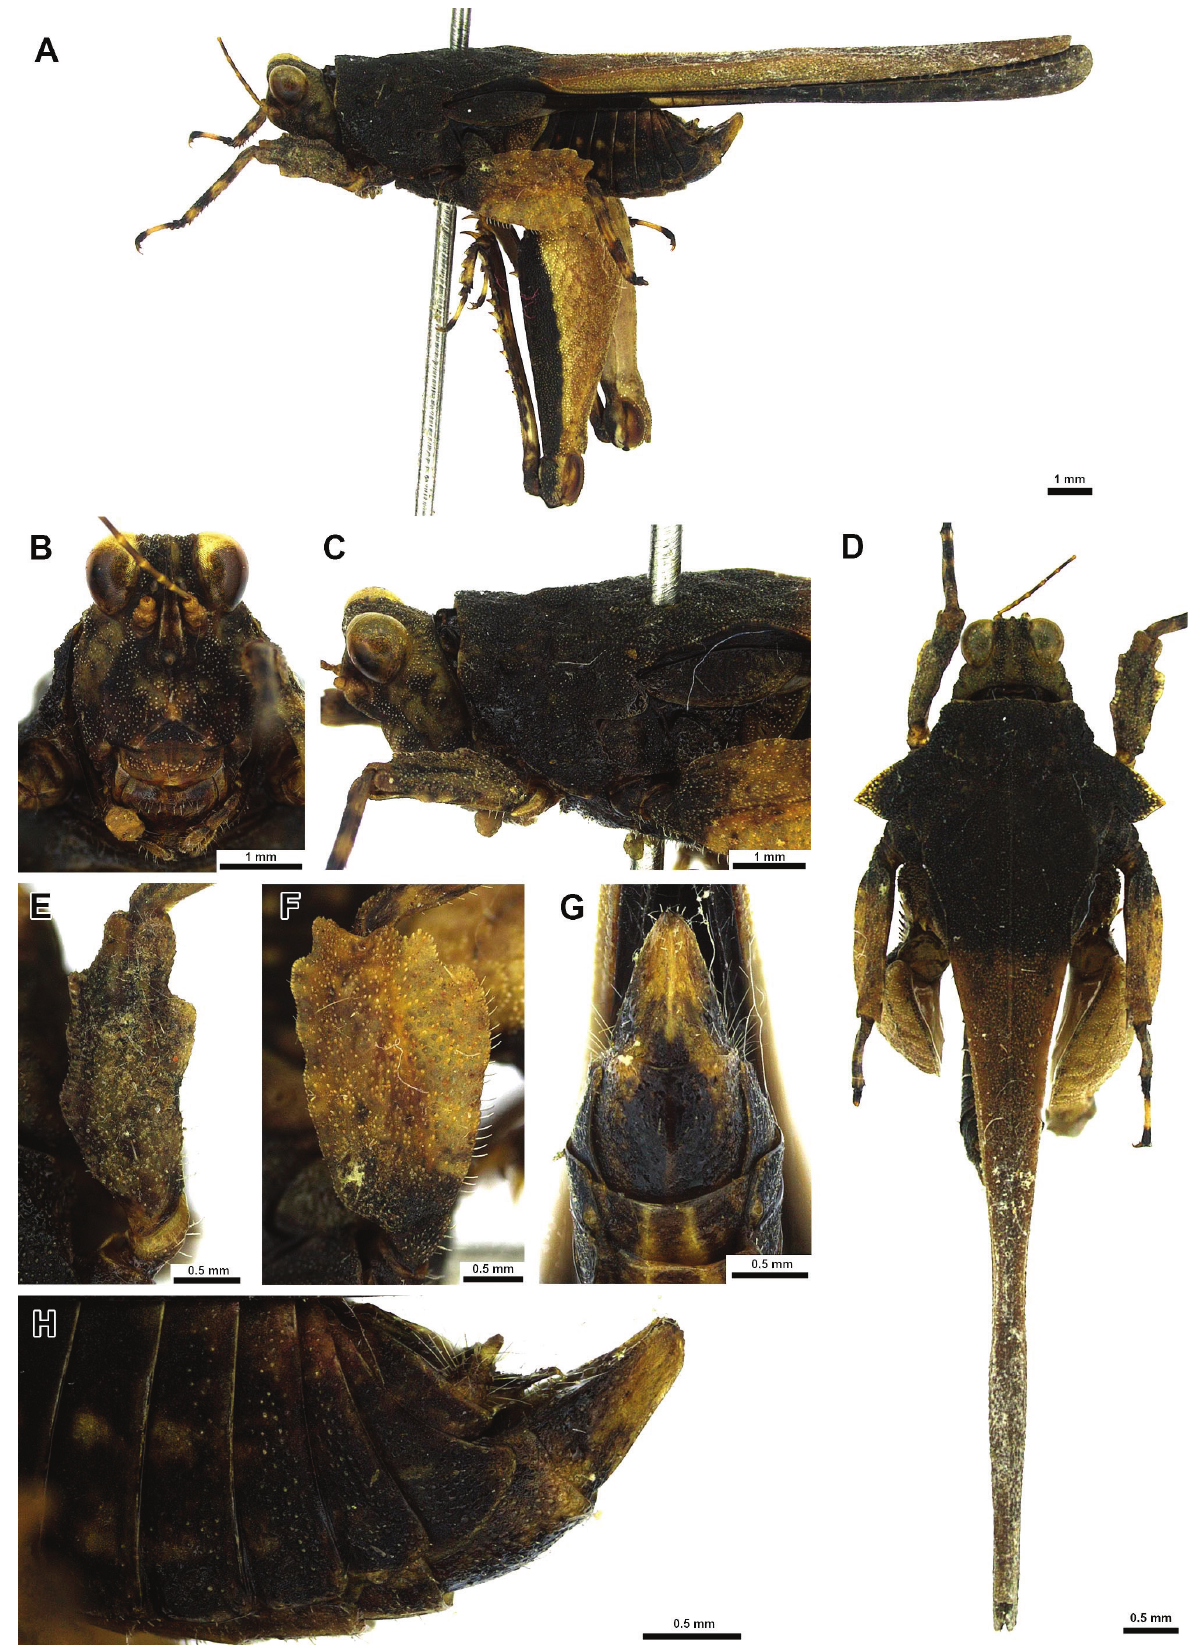
Fig. 9. Eomorphopus antennatus (male) A. Habitus in lateral view B. Frons; C. Head, lateral lobes of pronotum and tegmina in lateral view; D. Habitus in dorsal view; E. Fore-femur; F. Mid-femur; G. Terminalia in ventral view; and H. In lateral